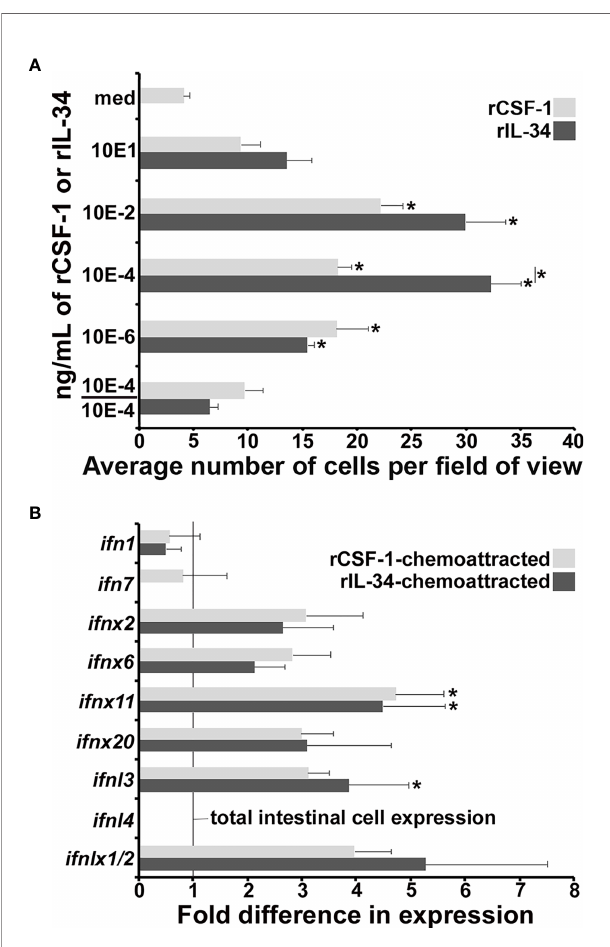
FIGURE 5 | Recombinant CSF-1 and IL-34 elicit chemotaxis of ifn - expressing cells from FV3-infected tadpole intestines. Tadpoles ( N =6) were infected by water bath with 10 6 PFU of FV3 for 6 hrs, their intestines isolated and dispersed into cell suspensions. (A) These cells were used in chemotaxis assays, performed against medium alone (med) or 10 - 10 -6 ng/ml of rCSF-1 or rIL-34 in bottom Boyden chamber wells (5 mm 2 ; N =3 for medium, 10, 10 -2 , 10 -6 ng/ml doses and N =9 for the 10 -4 ng/ml doses of either cytokine) loaded into top wells, separated by chemotaxis fi lters. After incubation the bottom faces of the fi lters were stained with Giemsa stain and examined for numbers of migrating cells (40x objective). Chemokinesis experiments were performed using 10 -4 ng/ml of rCSF-1 or rIL-34 (the most chemo-attractive concentration) in both bottom and the top chemotaxis chambers ( N =3). The results are means ± SE of cells per fi eld of view. Asterisks (*) denote statistical differences between medium alone and recombinant cytokine-induced migration (*) denote statistical differences between the treatment groups denoted by the line, p <0.05. (B) Cells chemoattracted by 10 -4 ng/ml of rCSF- 1 or rIL-34 ( N =6) were examined for their type I and III IFN expression relative to gapdh endogenous control. The results are means ± SE of gene expression. Asterisks (*) denote statistical differences from the respective ifn expression in total intestines, denoted by line, p